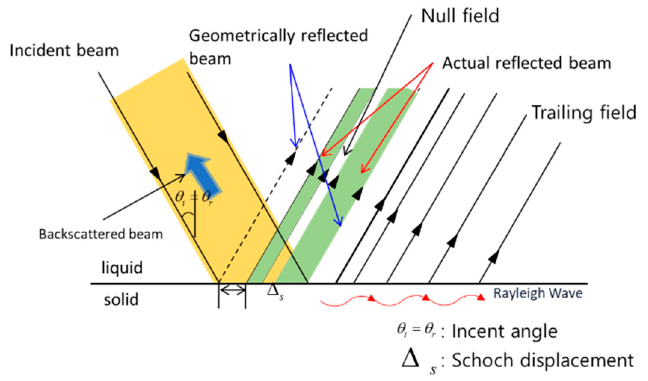
Figure 1. Diagram showing reflection field at Rayleigh angle.